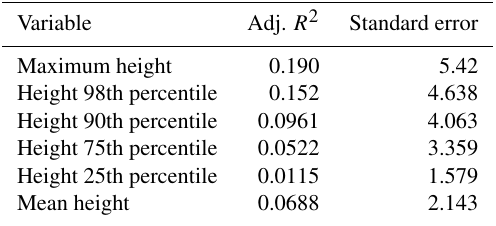
Table E1. Correlation coefficients for forest canopy height. Adj. R 2 : adjusted R 2